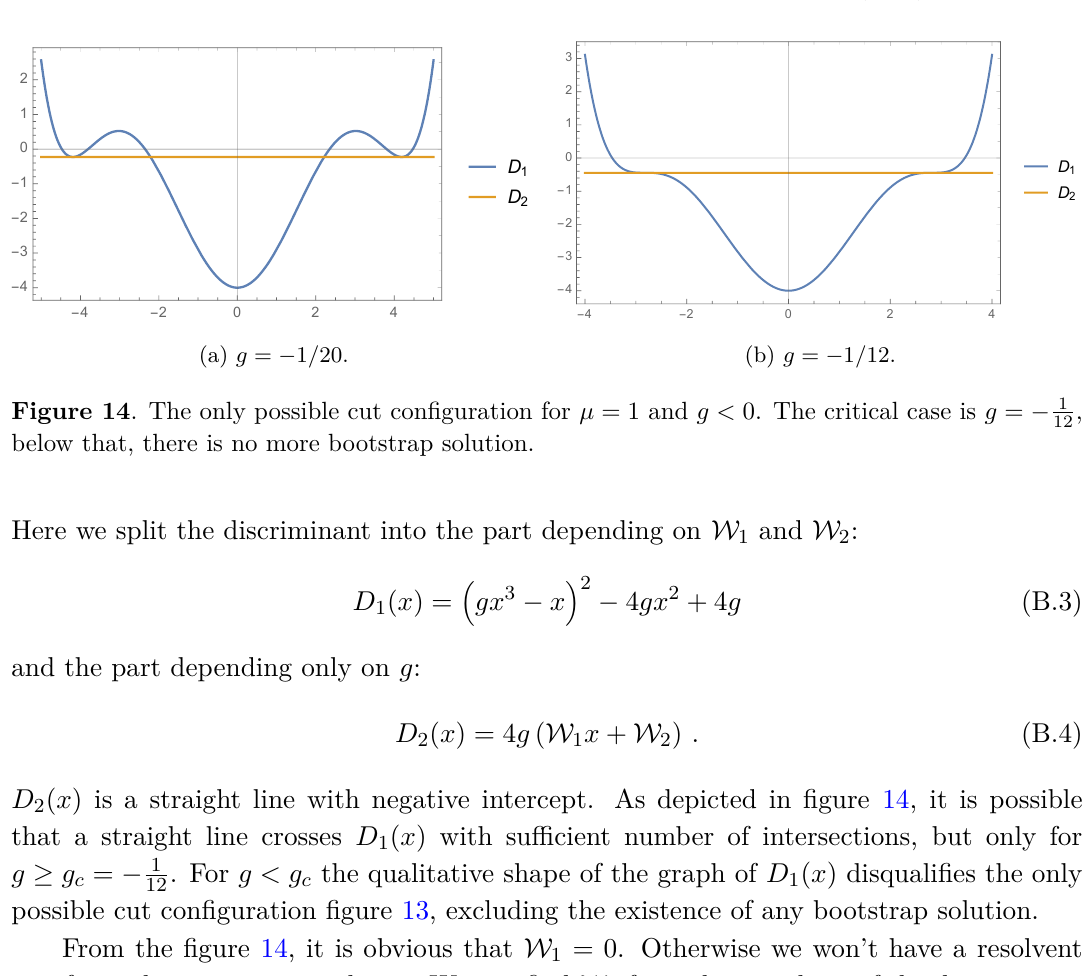
Figure 13 . The only possible cut configuration for asymptotic (+ , − ) .